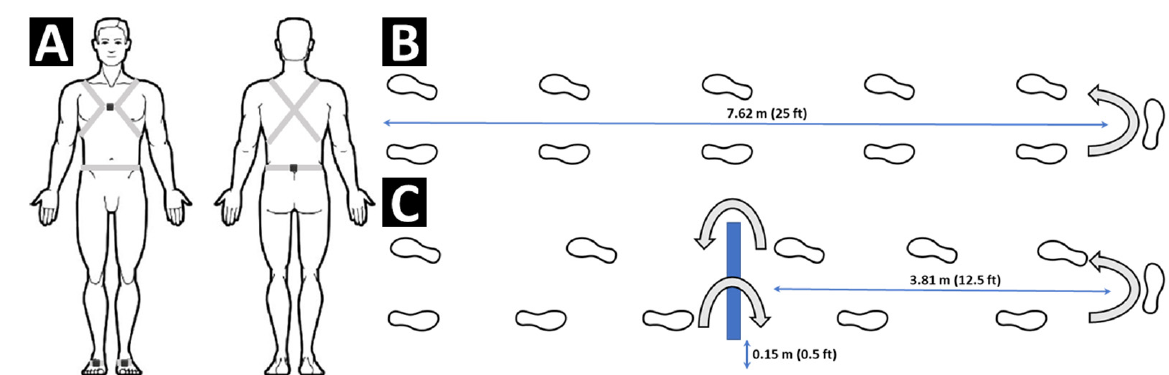
Figure 1. Inertial sensors placement ( A ) at the bilateral feet, chest, and lumbar spine and the sample courses for the walk and turn task ( B ) and walk and turn with obstacle task ( C ). For both tasks, the length of the course was 7.62 m (25 ft). The obstacle in the walk and turn with obstacle was placed at approximately 3.81 m (12.5 ft) from the starting position and was 0.15 m (0.5 ft) tall.